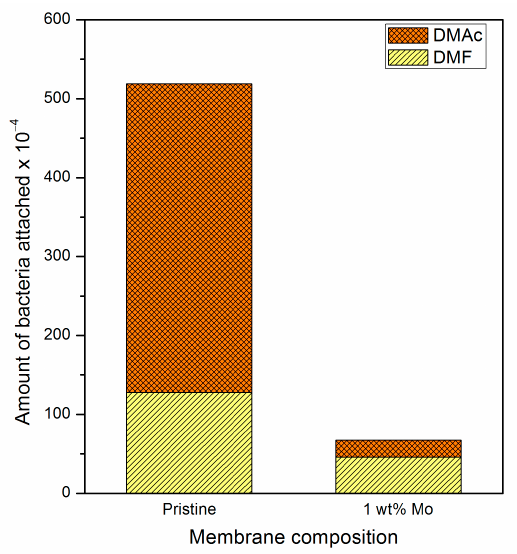
Figure 10. Amount of bacteria cells attached on membranes surfaces. The bacteria adhesion decreased due to the impregnation of Moringa seeds powder in the polymer matrix.